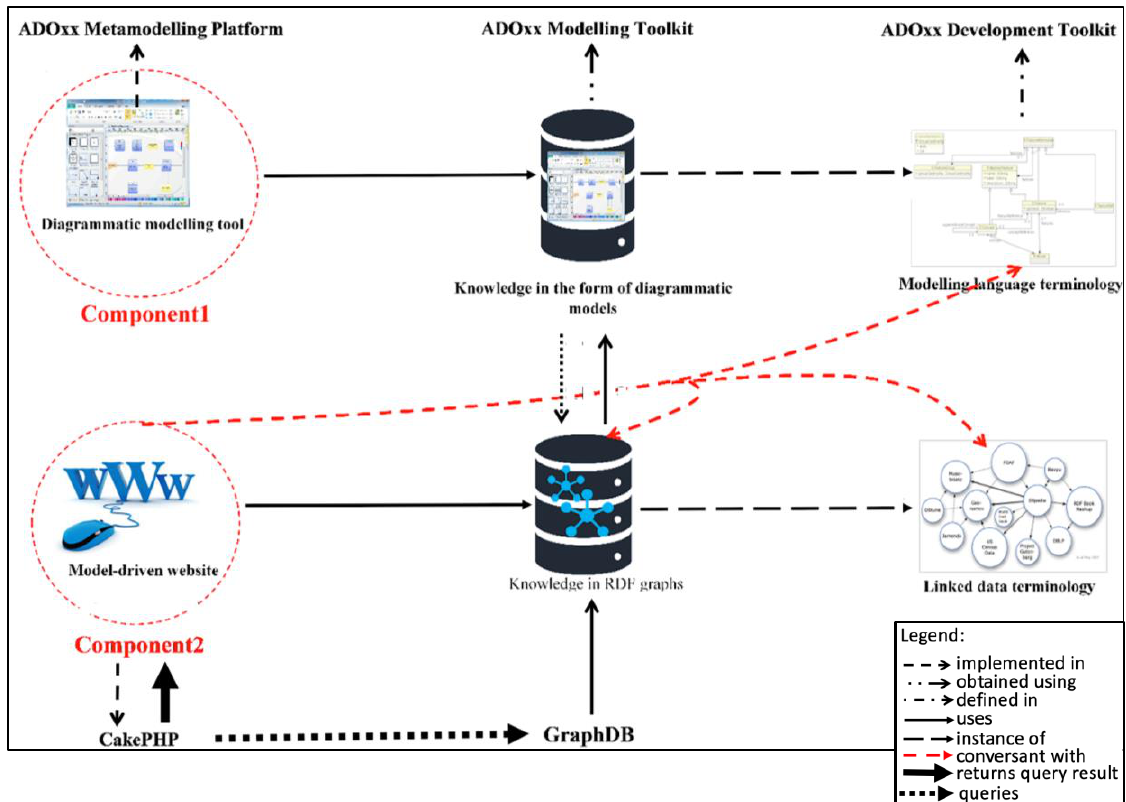
Figure 1. Architecture and interactions between the artifact